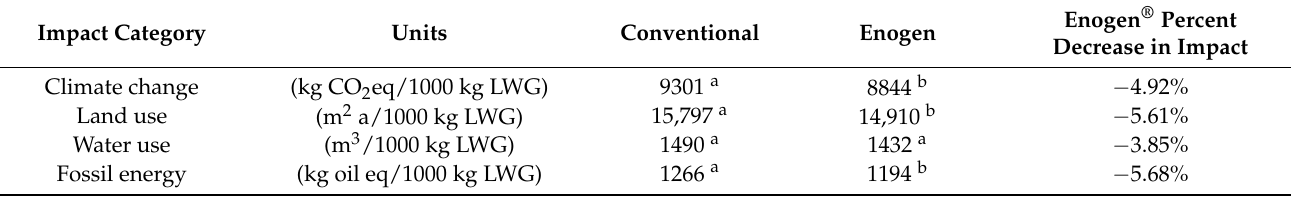
Table 7. Scenario 6: Environmental impacts and improvements for gate-to-gate UNL feed yard trial. IFSM modified the simulated larger animals with the same live weight gain as the UNL trial.